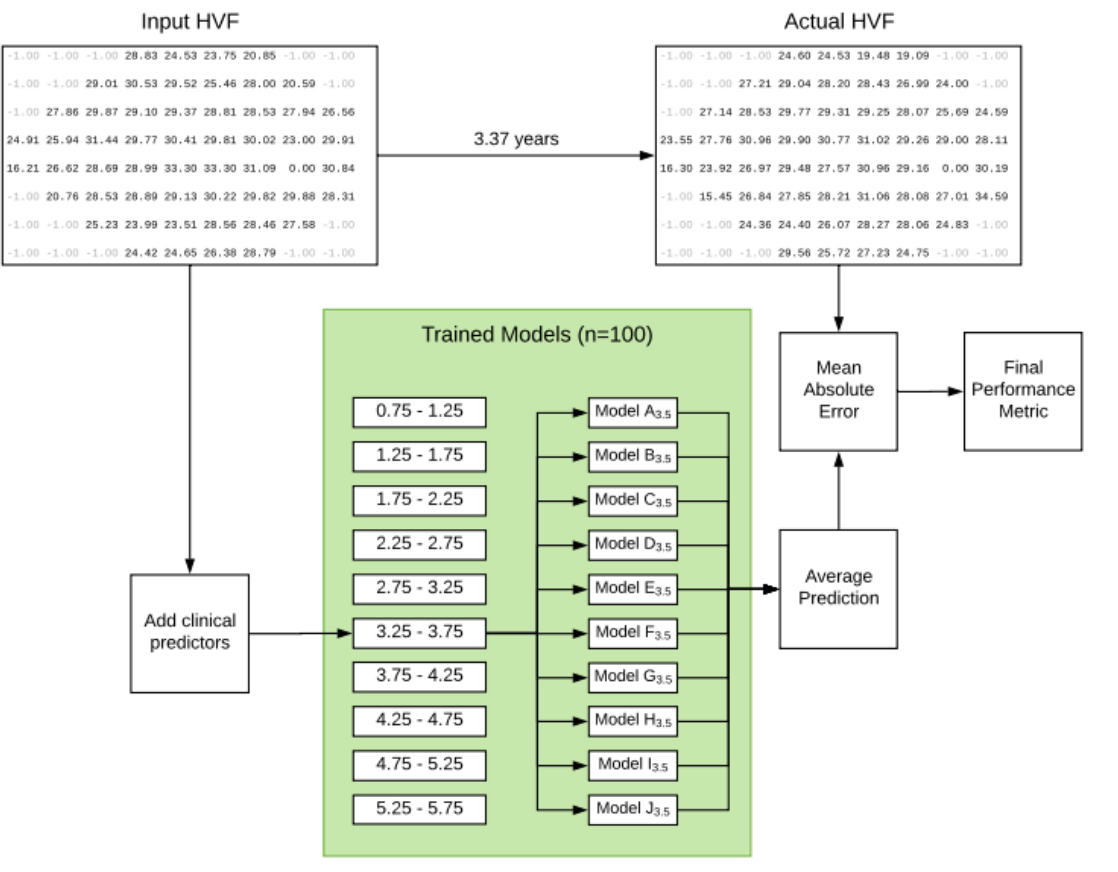
Figure 4. The sequence diagram of the model testing.